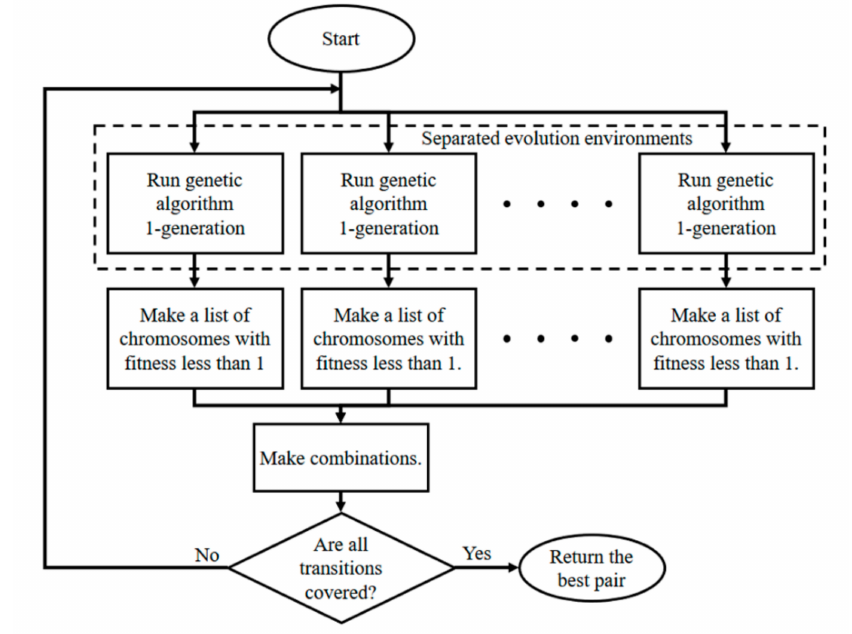
Figure 3. Feasible transition path (FTP) generation algorithm